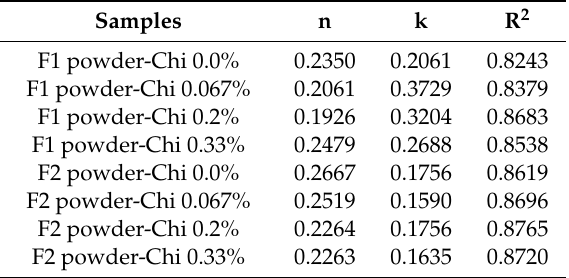
Table5. KineticdataofeugenolreleasedfrommicrocapsulesusingtheKorsmeyer–Peppaskineticmodel.